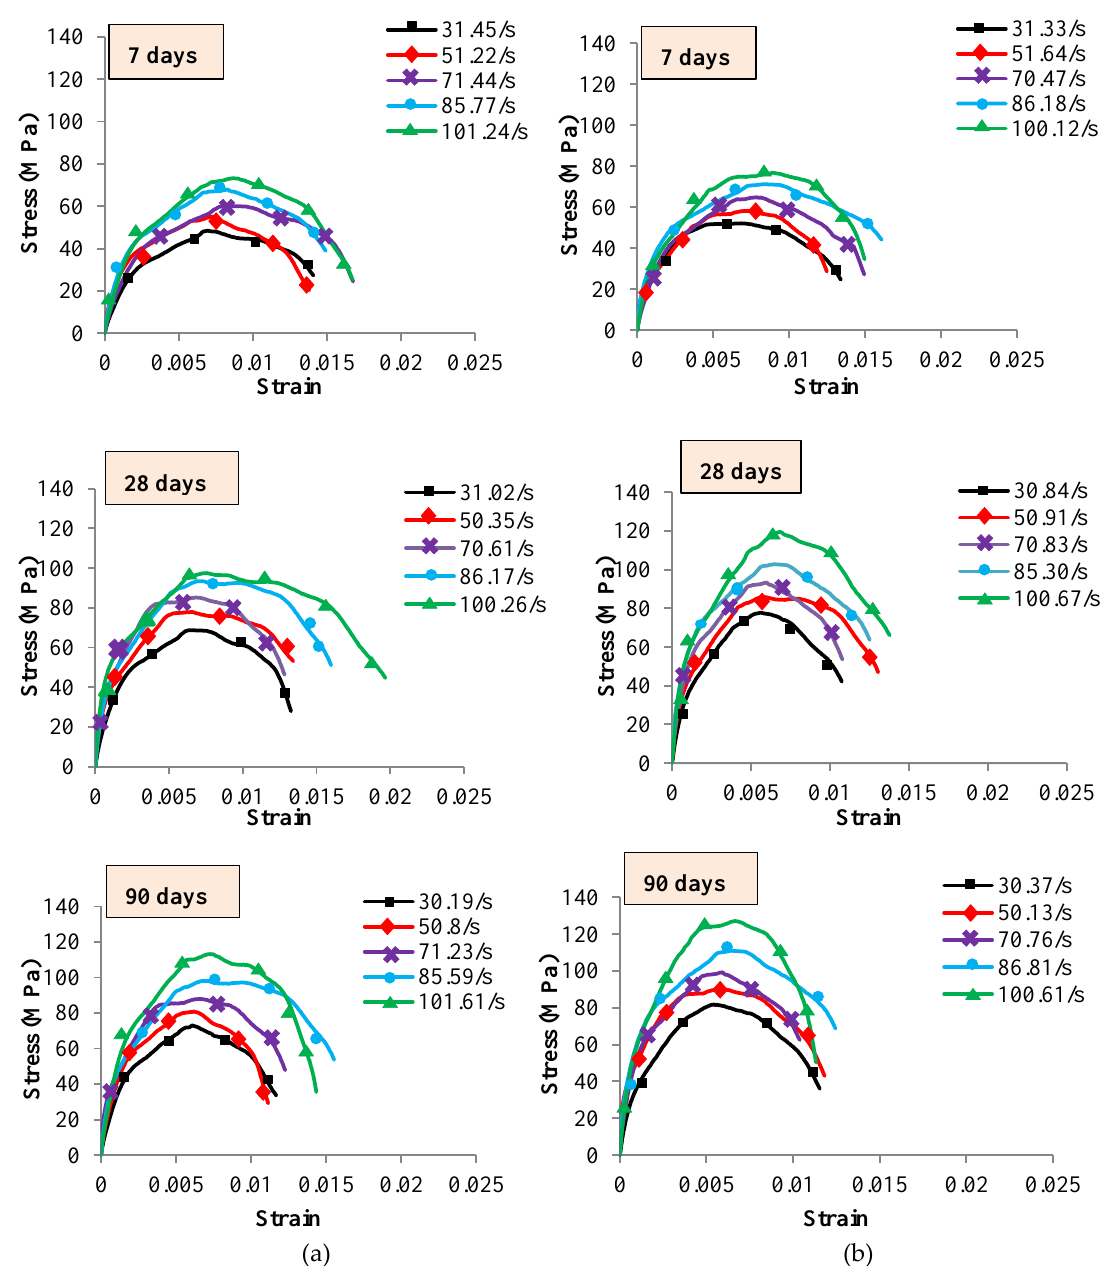
Figure 6. Stress–strain diagrams at 400 °C: ( a ) PC and ( b ) HVFANS concrete.